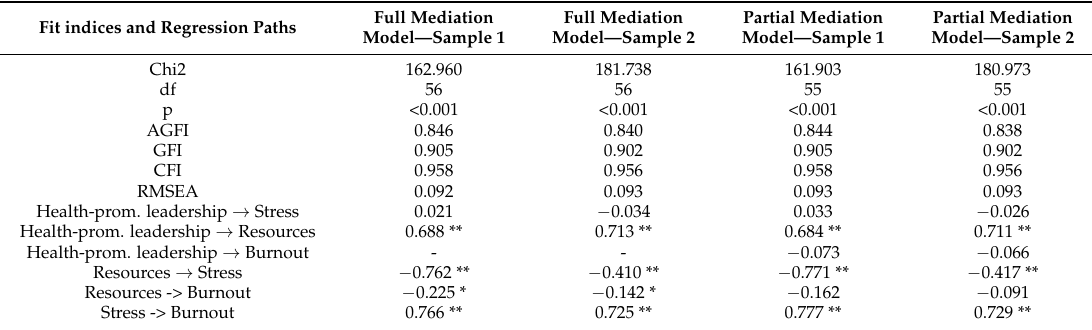
Table 8. Fit indices and path coefficients of the full mediation model and partial mediation